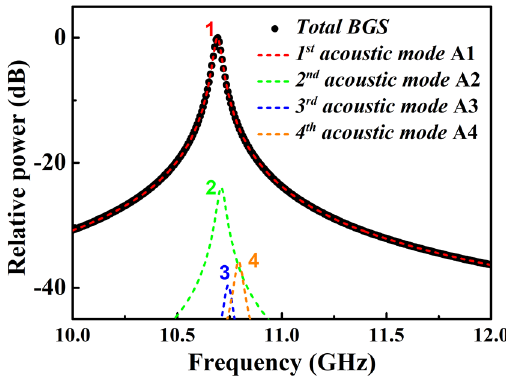
Figure 4. Numerical results of BGS of the MSI 2-LP-mode fiber.